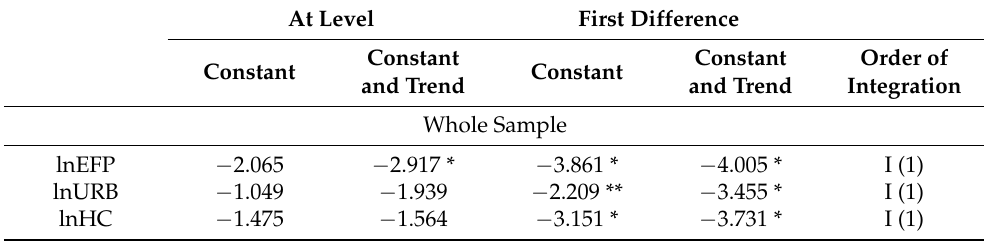
Table 5. CIPS cross-sectionally dependent unit root test